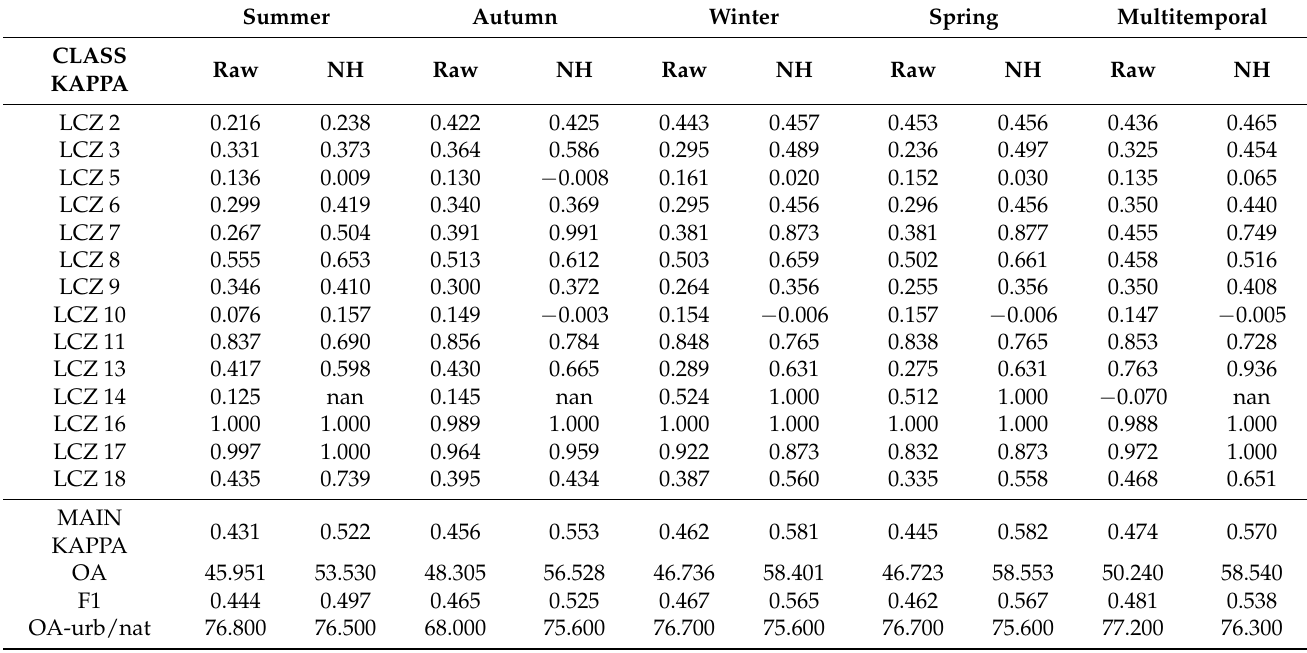
Table 8. East London, individual Kappa and overall accuracy metrics for single image and multitem- poral raw and neighborhood function with local customized